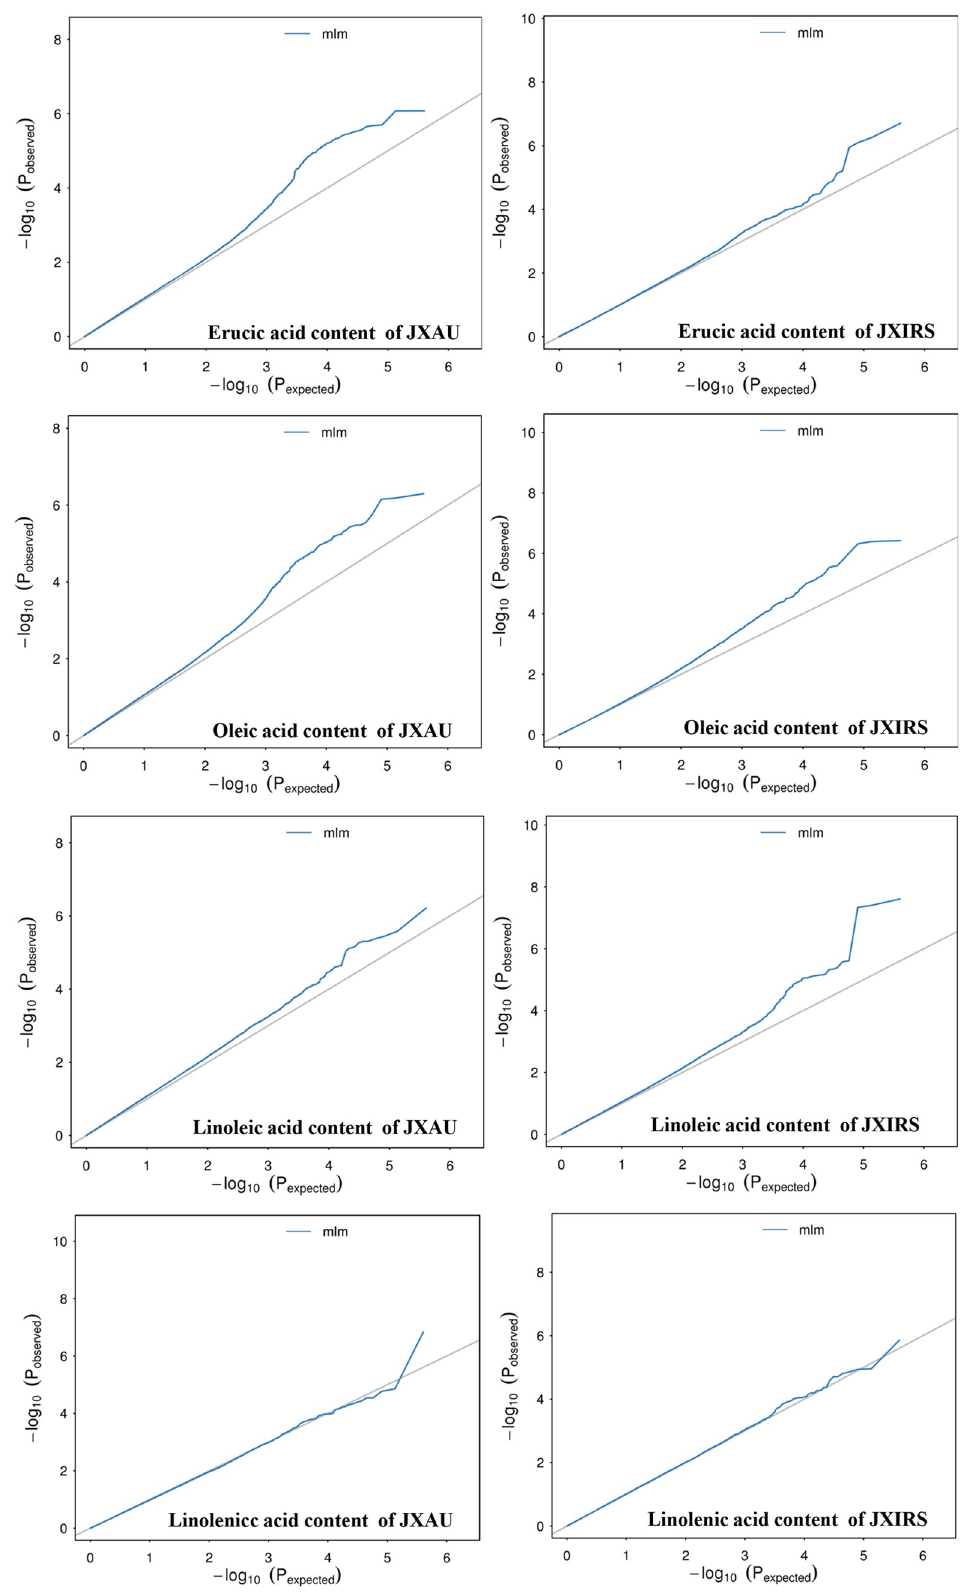
Fig 2. Quantile-quantile plots of estimated-lg (P) from association analysis of four fatty acid content traits using MLM model in two environments (JXAU and JXIRS). https://doi.org/10.1371/journal.pone.0221578.g002 PLOS ONE | https://doi.org/10.1371/journal.pone.0221578 August 23,